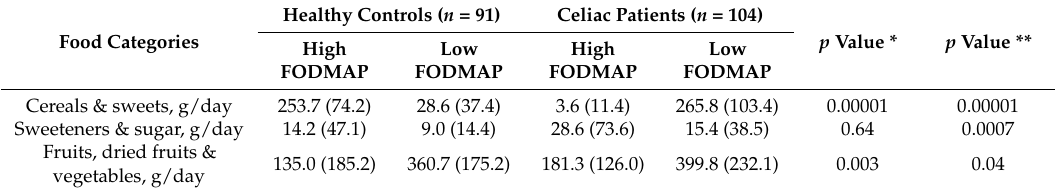
Table 4. Daily intake of grouped food categories containing low and high amounts of FODMAP by celiac patients and healthy